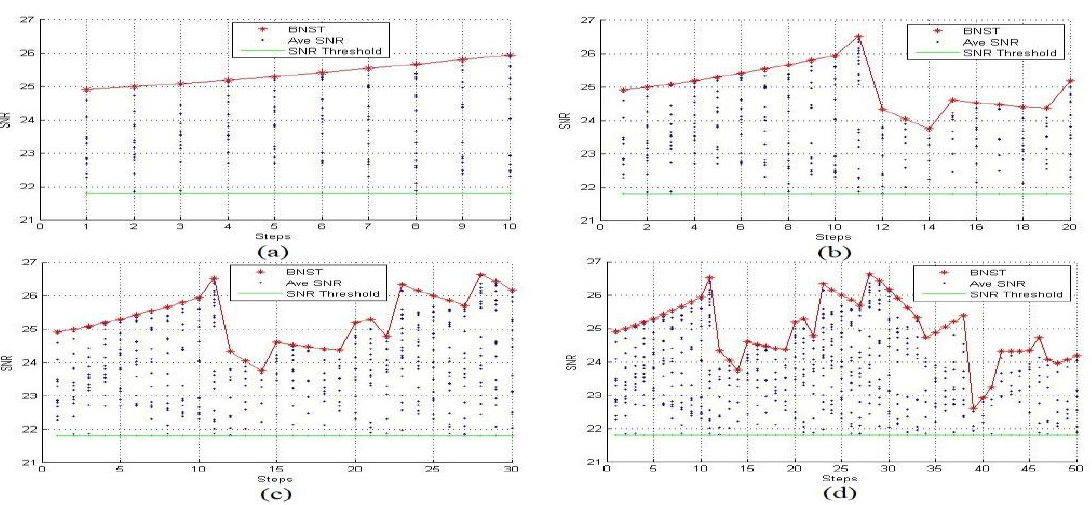
Figure 7. The average SNR computed at boundary nodes: ( a ) time steps = 10 s; ( b ) time steps = 20 s; ( c ) time steps = 30 s; and ( d ) time steps = 50 s.